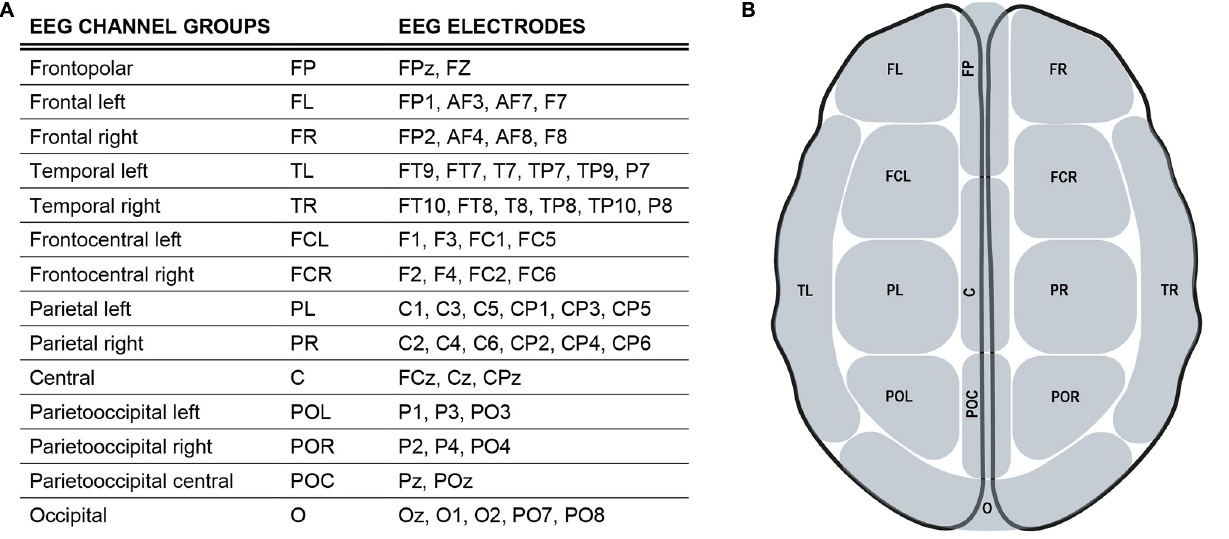
was computed from frequency domain data. Finally,